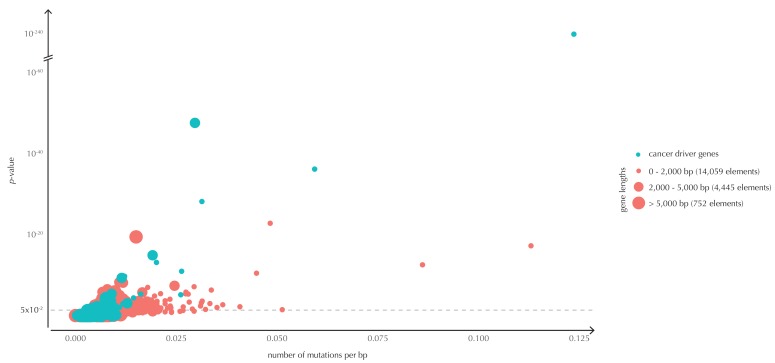
The p-values (based on conservation scores) plotted as a function of the total number of mutations across samples observed per bp for all protein-coding genes.The point size indicates gene length. The mean number of mutations per bp is on average eight times higher for the COSMIC genes detected by ncdDetect compared to the undetected COSMIC genes.DOI:
http://dx.doi.org/10.7554/eLife.21778.01910.7554/eLife.21778.020Figure 4—figure supplement 2—source data 1.For each protein-coding gene, the gene length, the number of observed mutations across all 505 samples, and the p-value obtained using conservation scores are given.Furthermore, the COSMIC status is indicated. This data set relates to Figure 4—figure supplement 2.